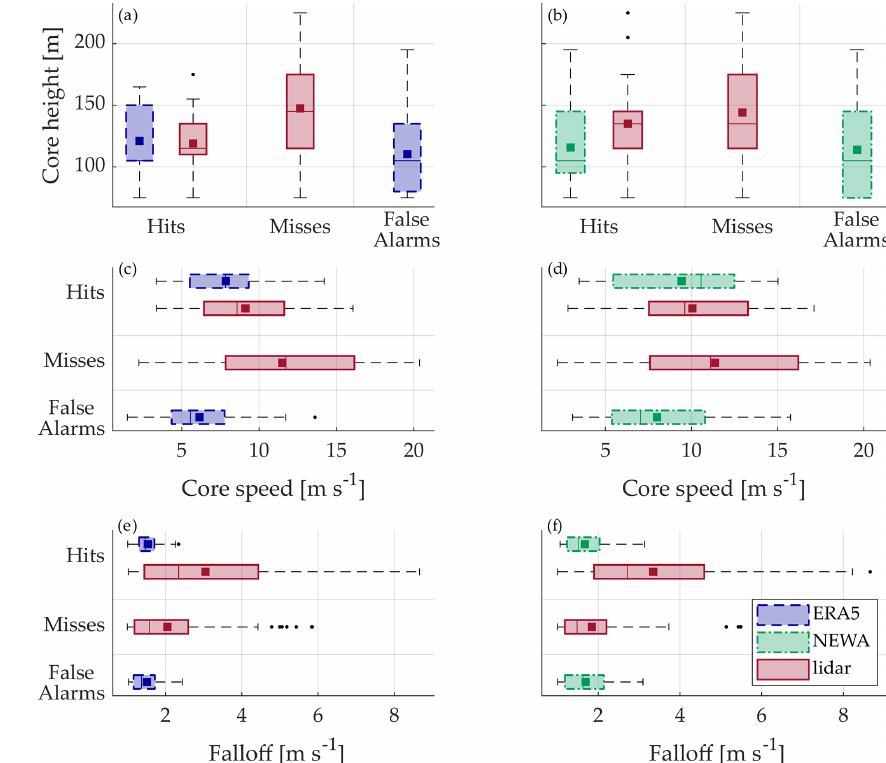
Figure 11. Boxplots showing the core height (a, b) , core speed (c, d) , and falloff (e, f) for the different datasets and classified according to hits, misses, and false-alarms events. The bottom and the top edges of the boxes indicate the 25th and 75th percentiles, respectively. The line inside the box is the median and the square is the mean. The whiskers extend to the extremes, defined as a distance of 1.5 times the interquartile range (IQR) above and below the upper and lower quartiles, respectively. The outliers are represented by the black